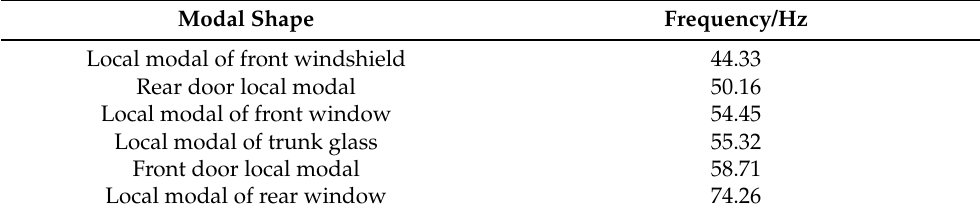
Table 2. Modal shapes and frequencies of doors and